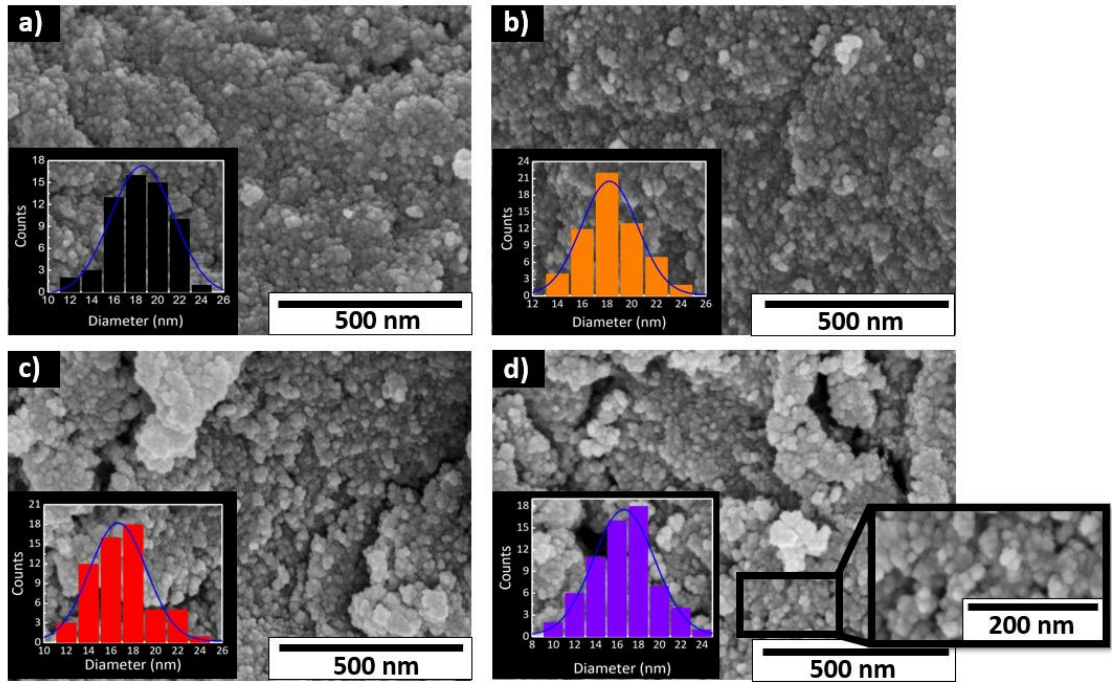
Figure 2. SEM images and insets showing the Gaussian model (in blue) for fitting the histograms of ( a ) pure TiO 2 , ( b ) 1 mol% of Fe-TiO 2 , ( c ) 2 mol% of Fe-TiO 2 , and ( d ) 5 mol% of Fe-TiO 2 nanoparticles prepared by microwave irradiation using